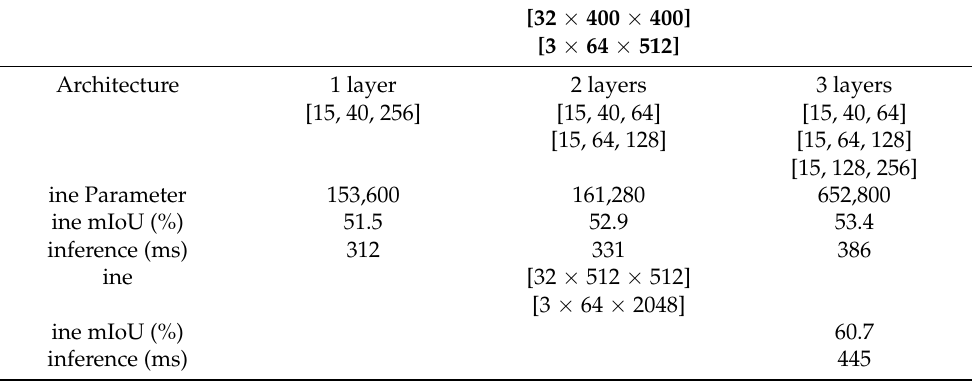
Table 4. Parameter and performance for KPConv-based fusion. The fusion struggles to handle large projection errors. Using larger projections to decrease the projection error brings significant improvement for the fusion (Bird’s-Eye: 50.1, Spherical: 54.8).